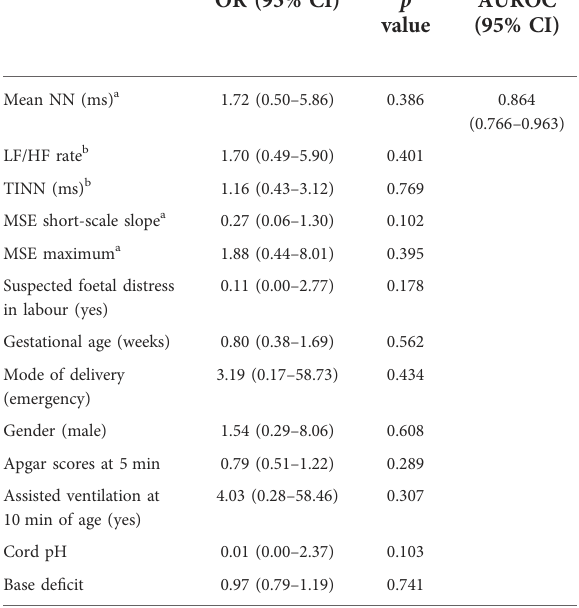
TABLE 7 Subgroup analysis of infants undergoing therapeutic hypothermia - HRV and clinical prediction model, n =52